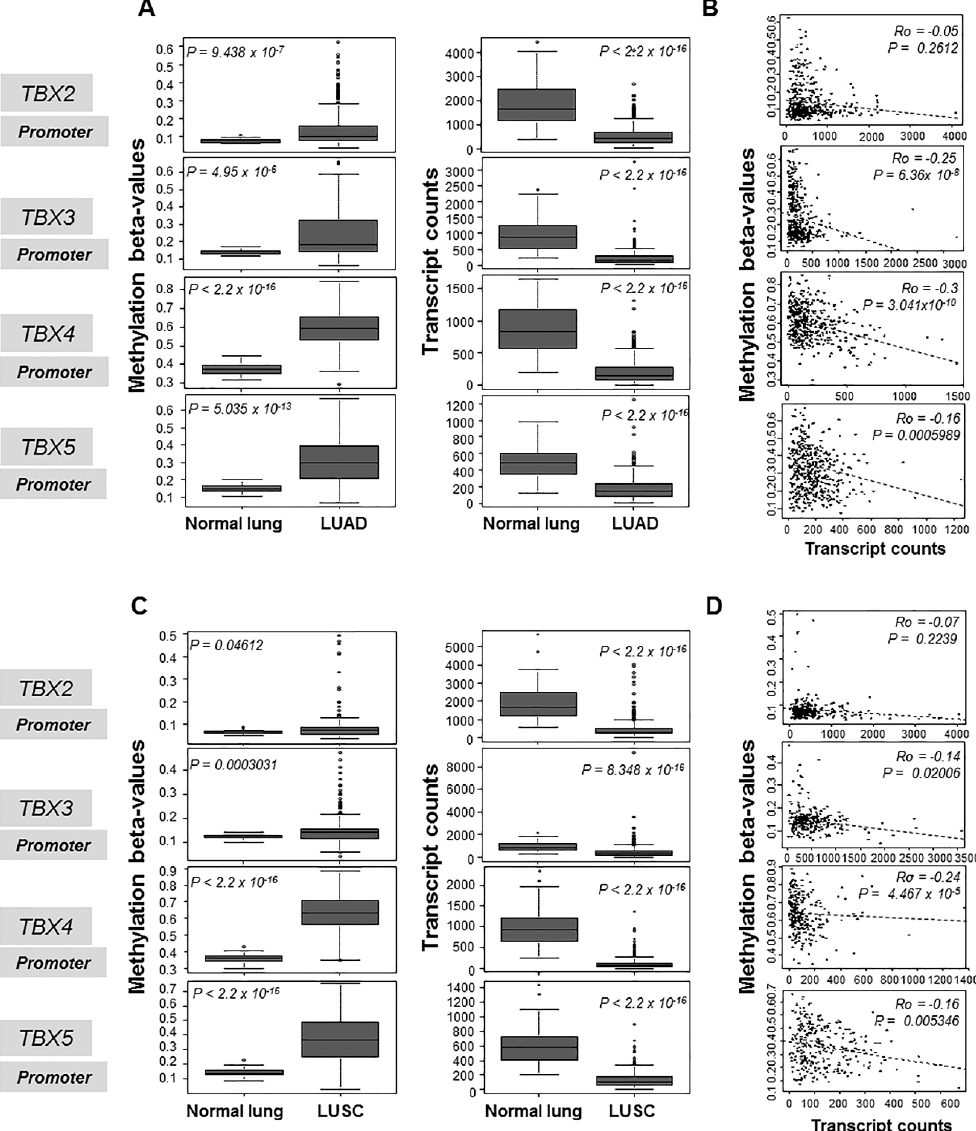
Figure 1. Increased promoter-level methylation of the TBX2 subfamily in human LUADs and LUSCs compared to normal lung tissues. Promoter-level methylation β -values (left panels) and mRNA levels (right panels) in 460 LUADs ( A , B ) and 370 LUSCs ( C , D ) were propagated from the MethHC database of methylation and gene expression in cancer. Methylation β -values and mRNA levels of the TBX